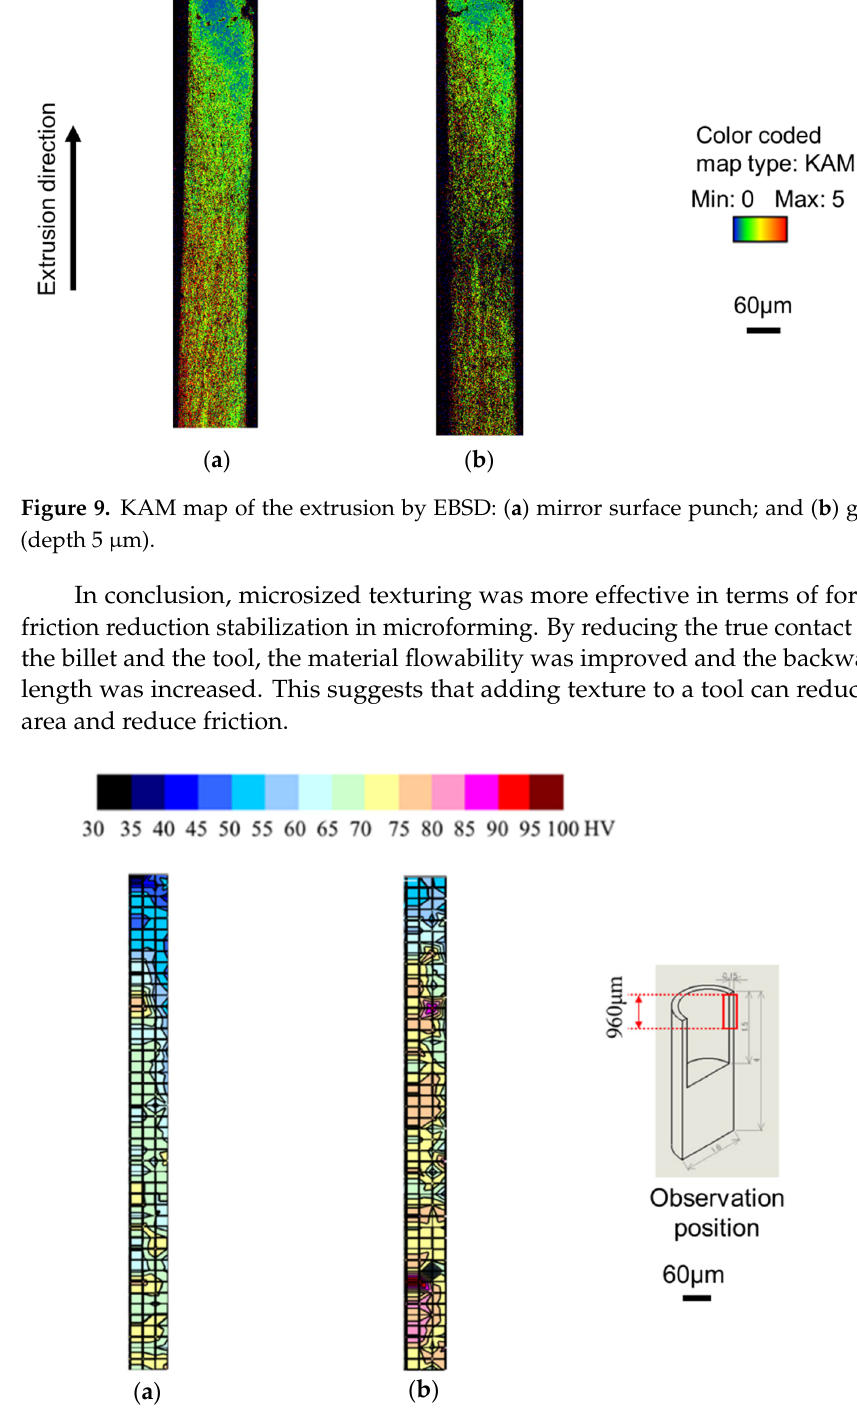
Figure 9. KAM map of the extrusion by EBSD: ( a ) mirror surface punch; and ( b ) grooved punch (depth 5 µm).